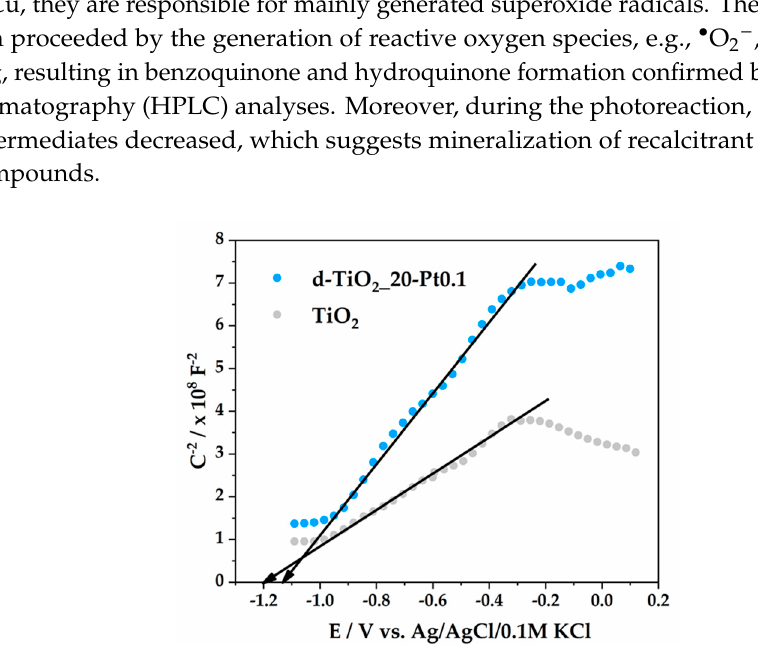
Figure 11. The Mott–Schottky plot for the bare and Pt modified d-TiO 2 .